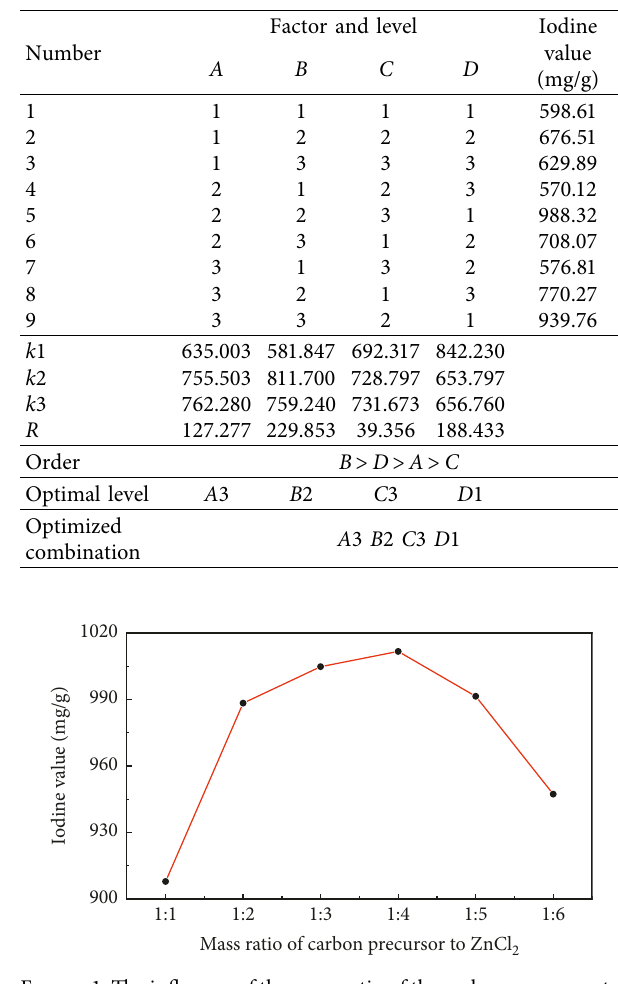
Table 1: Mass fractions of elements in the carbon precursor. Elemental composition and their mass Sample